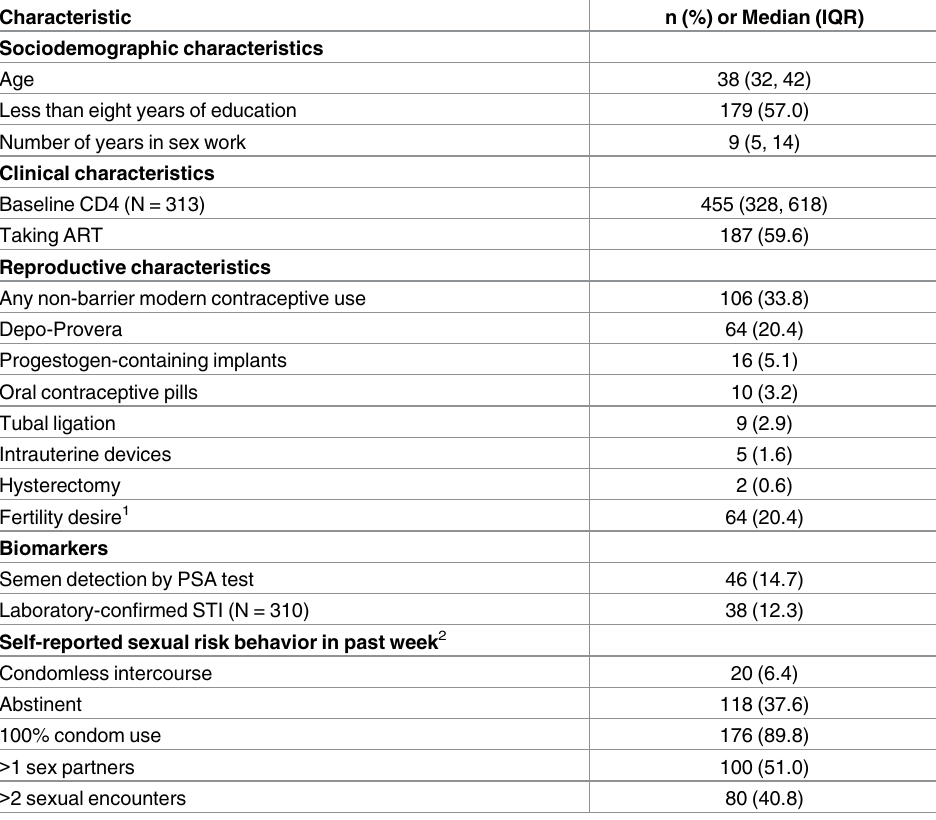
Table 1. Baseline characteristics of 314 HIV-positive female sex workers in Mombasa,